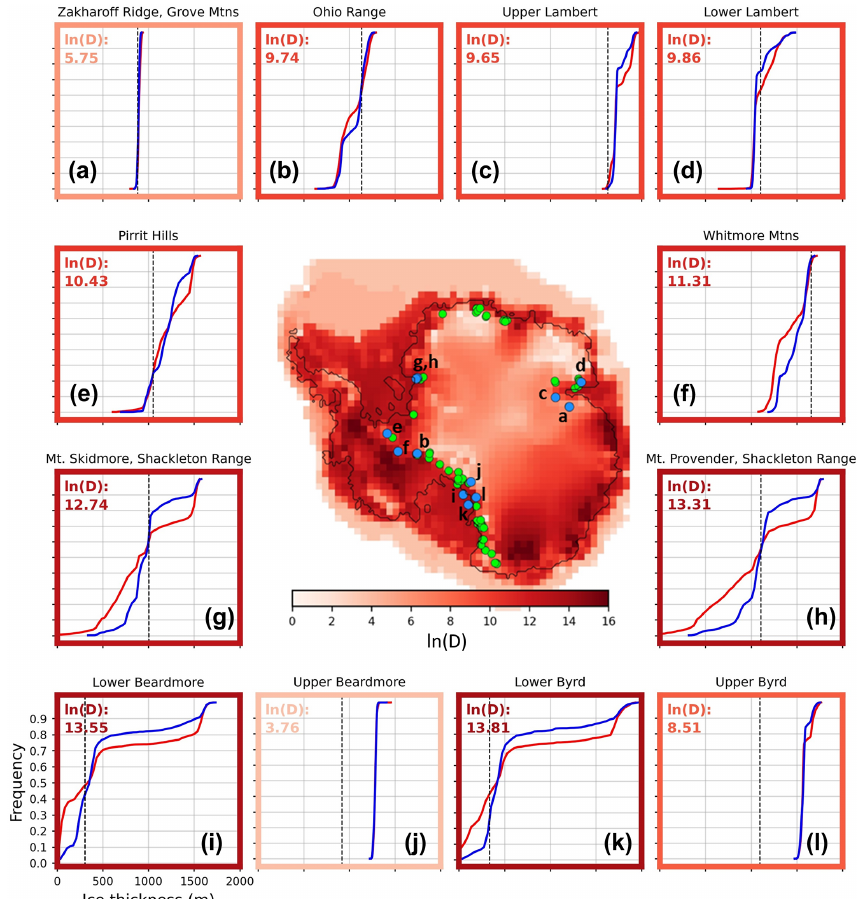
Figure 7. Central plot shows the 5Ma CDF difference metric ln( D ) as shown in Fig. 6a, compared with areas where comparable geologic estimates of ice thickness CDFs could be collected. The green dots are locations where cosmogenic-nuclide data from bedrock at interior nunataks indicate exposure histories longer than 1Ma, implying the possibility of generating observational ice thickness CDFs integrated over 1Ma or longer. The surrounding panels (a–l) display ice thickness CDFs for the sensitized (red lines) and desensitized (blue lines) model at selected sites (azure blue dots) where some cosmogenic-nuclide data with ages > 1Ma exist. The upper and lower Lambert Glacier, Beardmore Glacier, and Byrd Glacier sites are representative rather than exact data locations, because the coarse resolution of the model means that existing exposure-age datasets collected adjacent to these glaciers do not fall into the model grid cell corresponding to the glacier location. Thus, we plot ice thickness CDFs at a nearby representative grid cell. Dashed black lines are approximate (see discussion below in Sect. 6.2) representations of the present ice thickness at these locations derived from a reference model that reproduces the modern ice sheet configuration. Sites of exposure-age data represented by green dots are derived from the ICE-D: ANTARCTICA